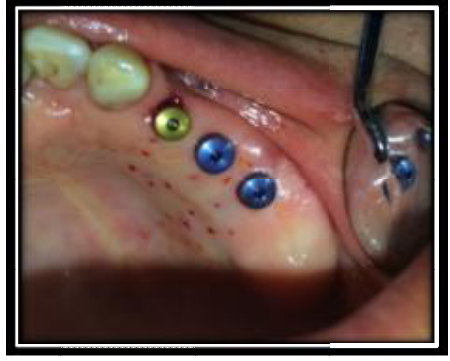
Fig. 5: Implants placed with flapless technique with their gingival formers.